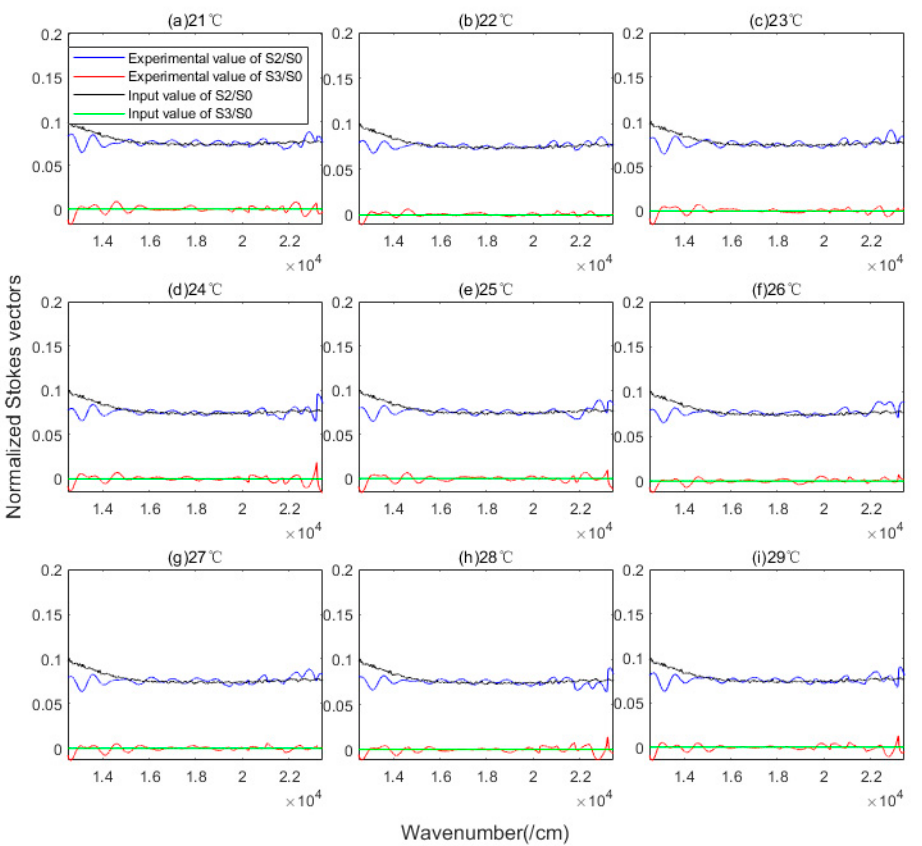
Figure 7. Normalized reconstructed S 2 / S 0 , S 3 / S 0 at different